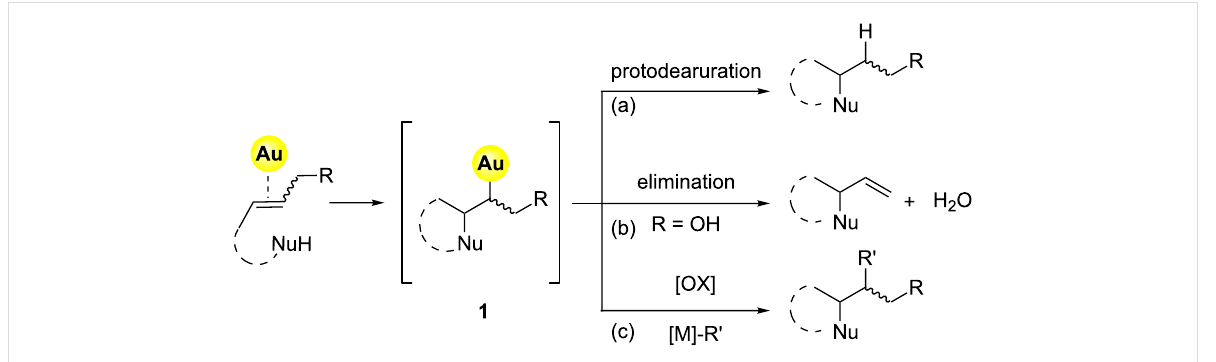
Figure 2: Different approaches for the gold-catalyzed manipulation of inactivated alkenes.